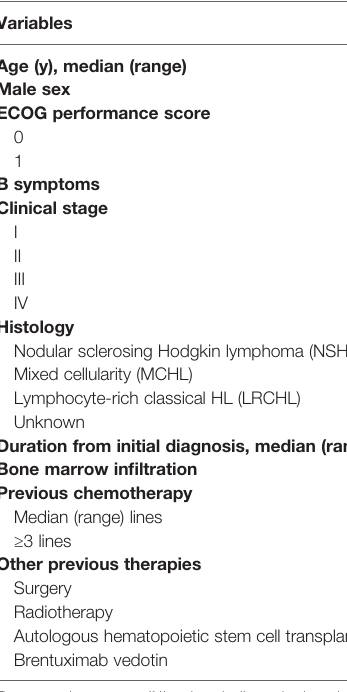
TABLE 1 | Patient demographic and baseline